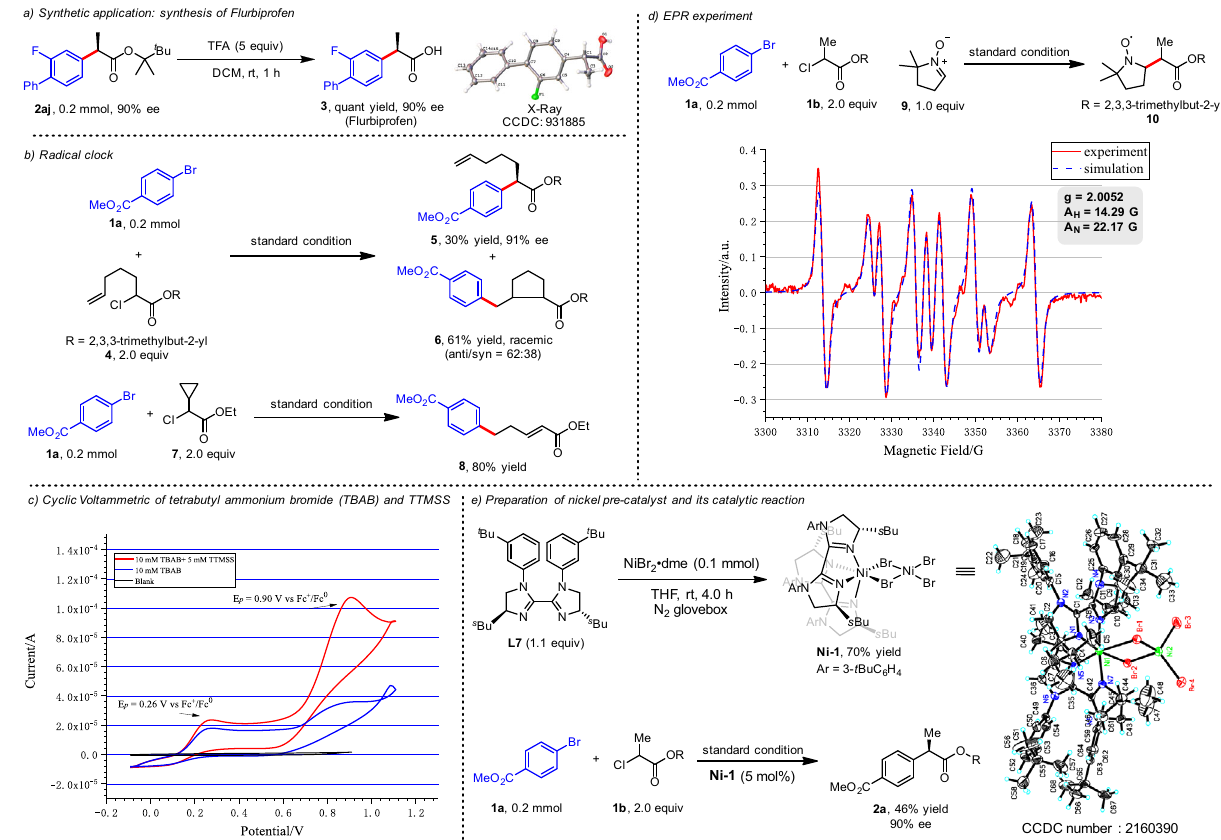
Fig.3|Syntheticapplicationandmechanisticstudies.a Syntheticapplication:synthesisof fl urbiprofen. b Radicalclock. c Cyclicvoltammetricoftetra-butylammonium bromide (TBAB) and TTMSS. d EPR experiment. e Preparation of nickel precatalyst and its catalytic